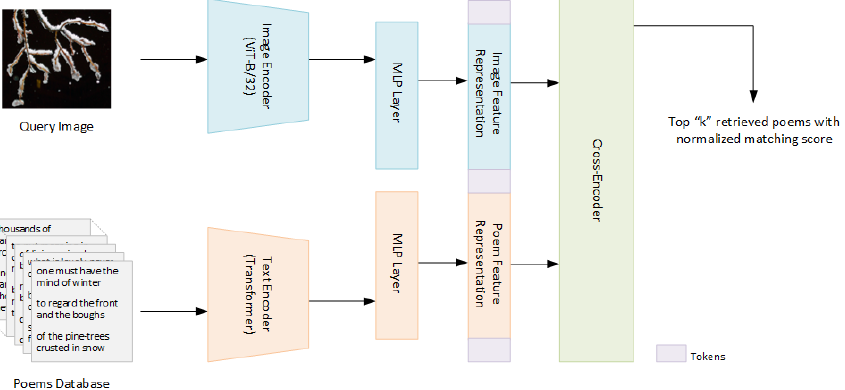
Figure 1. Flow diagram of the proposed approach. We use task agnostic transformers as image and poem encoders to obtain image and poem representations. Next, we concatenate tokens, images, and poem representations. Finally, we use a transformer model in the cross-encoder fashion, allowing shared attention parameters to learn discriminative image–text multi-modal information.